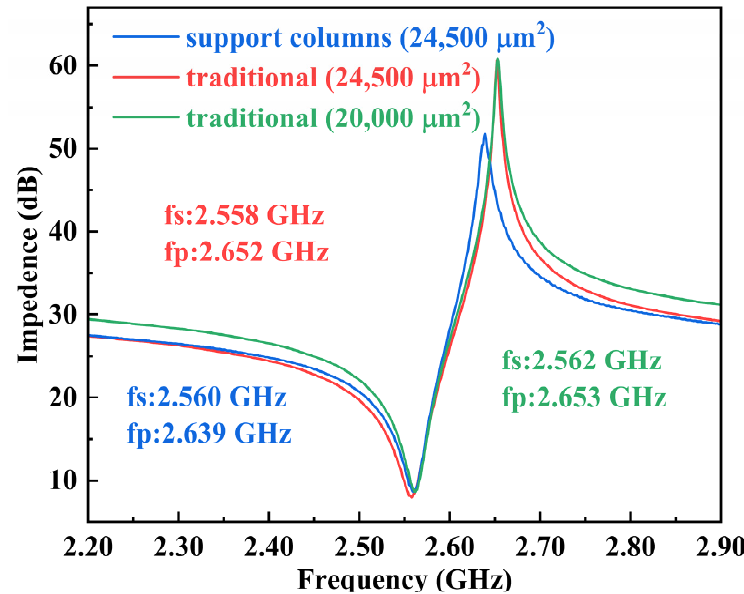
Figure 6. The measured results of different FBARs.